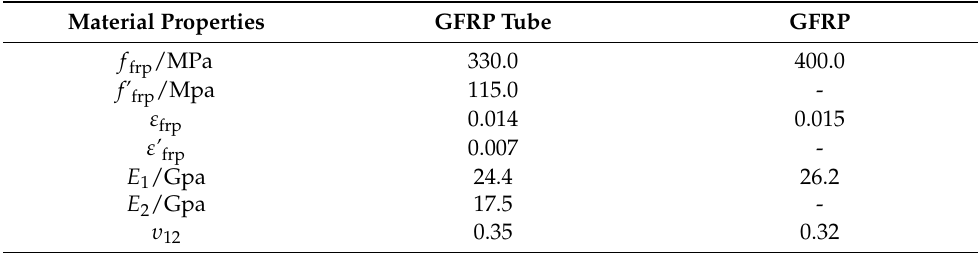
Table 2. Mechanical properties of composite materials.